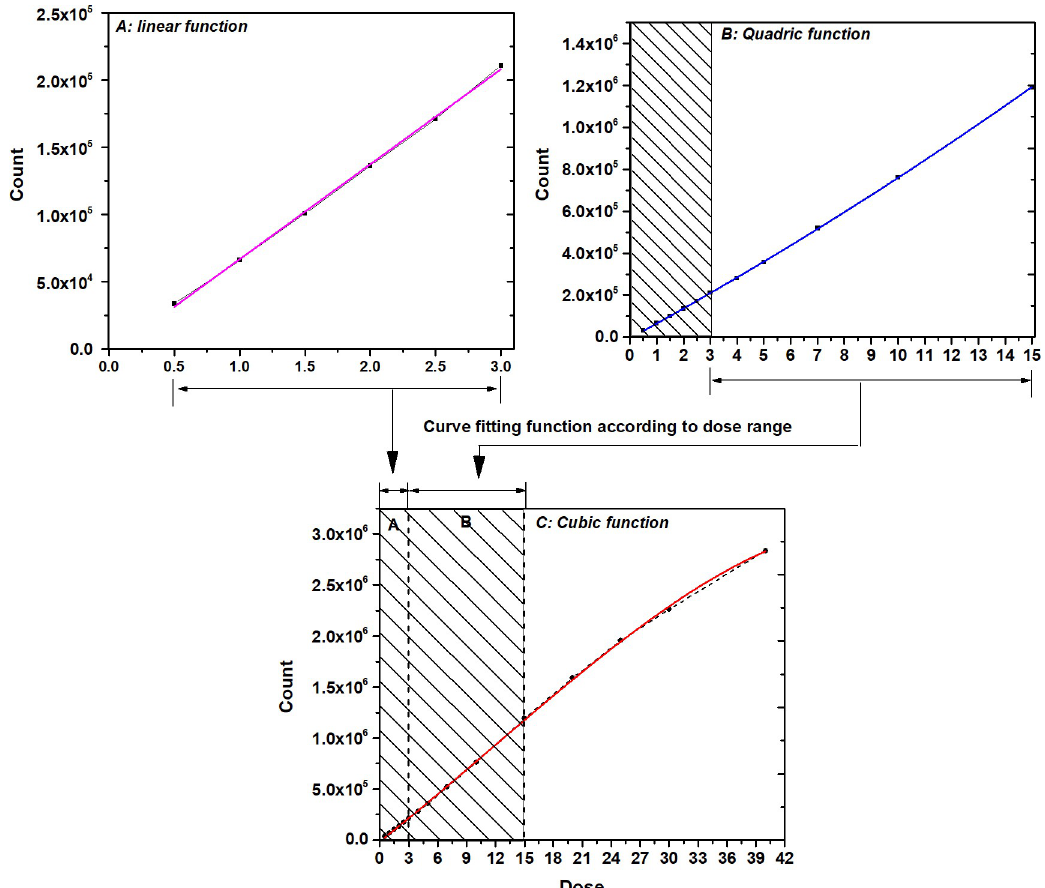
Fig 4. Curve fitting functions of the dose-response curve for dose evaluation according to the dose range of the OSLD. A: Linear function, B: Quadratic function, C: Cubic function.